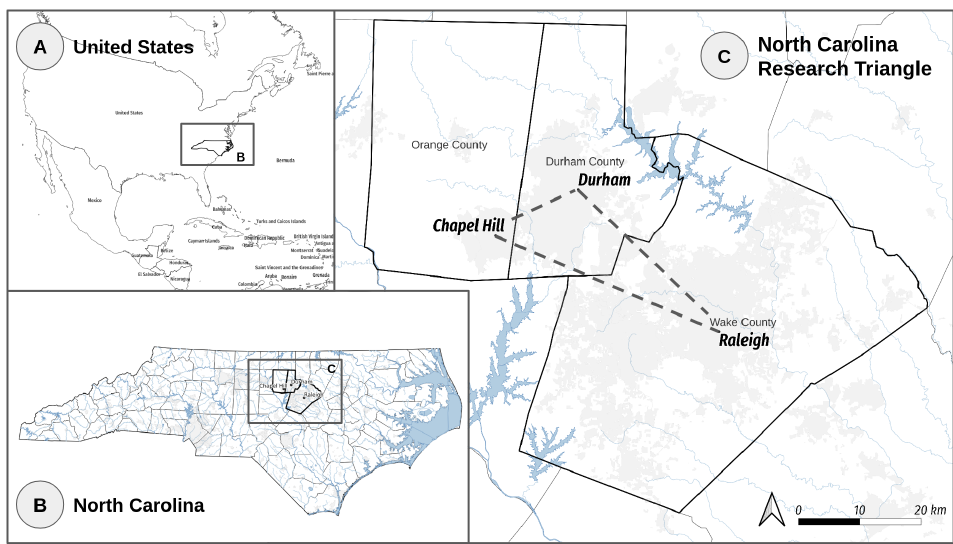
Figure 1. The North Carolina ( B ) Research Triangle ( C ) region (USA ( A )) includes the Town of Chapel Hill, the City of Durham, and the City of Raleigh, and a number of other communities. The area has a rapidly growing population, now estimated at 1.6 million (2020).